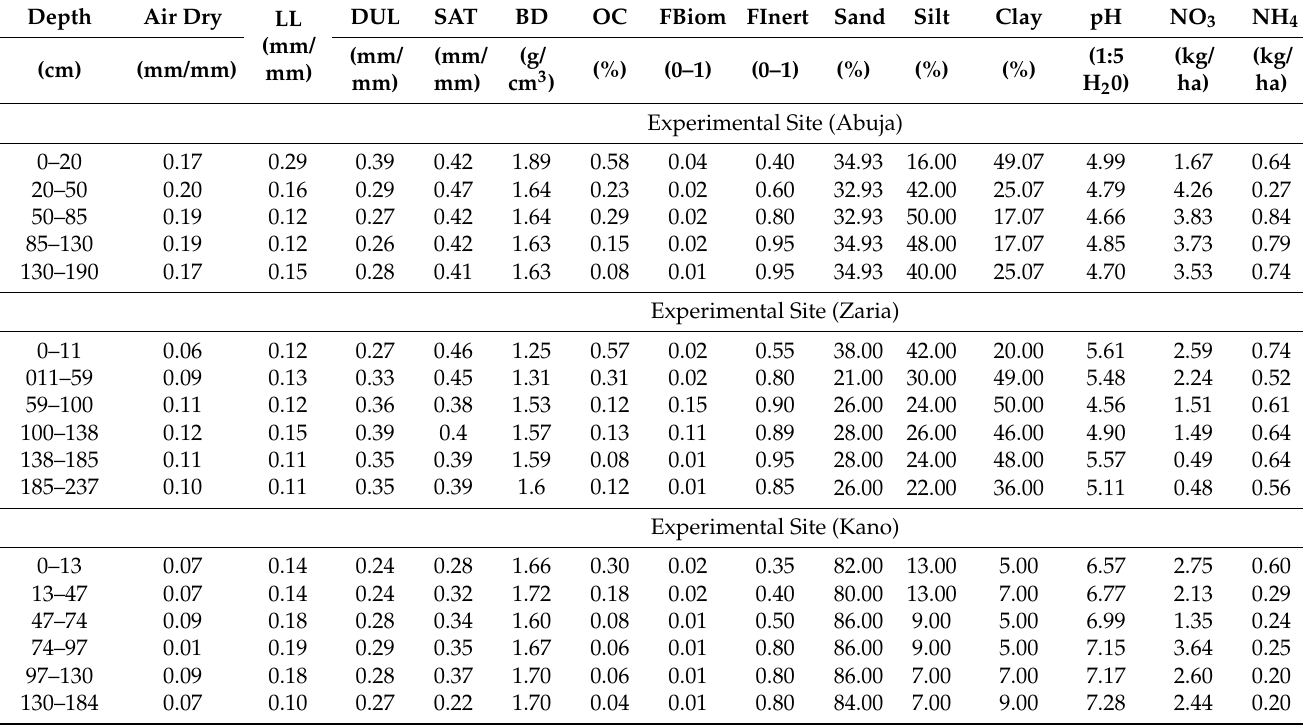
Table 1. Soil physical and chemical properties used for the model application